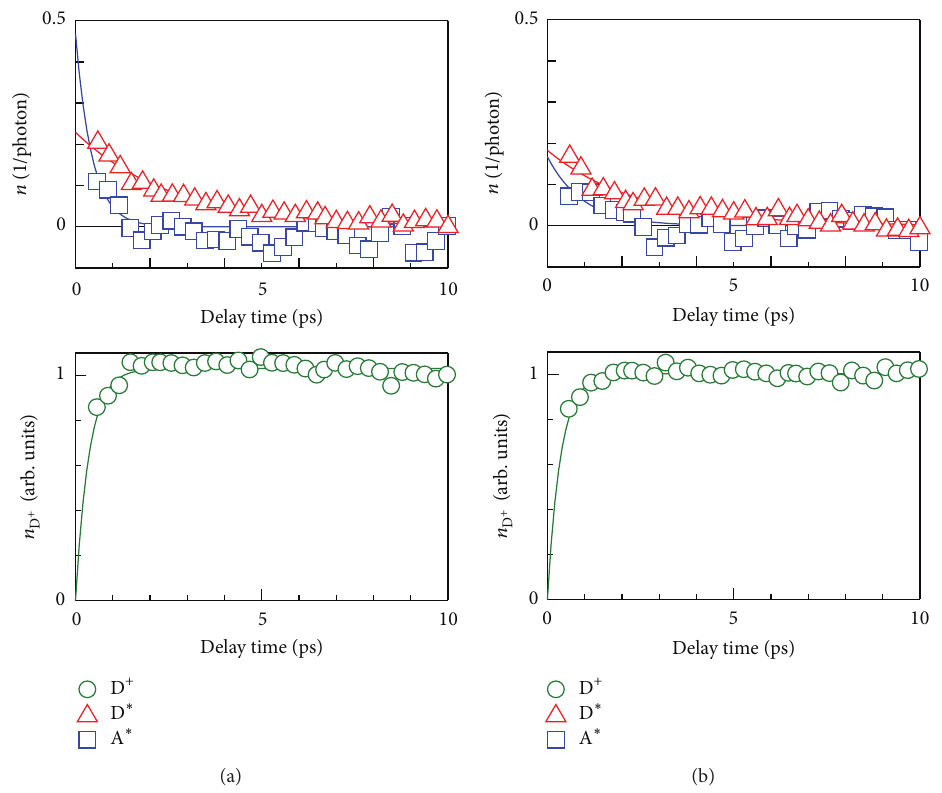
Figure 17: 𝑛 D + , 𝑛 D ∗ , and 𝑛 A ∗ per an absorbed photon against the delay time in SMDPPEH/PC 71 BM blend film at (a) 300 K and (b) 80K. Adjacent averages were plotted in 𝑛 A ∗ . The solid curves are results of the least-squares fittings with exponential functions.